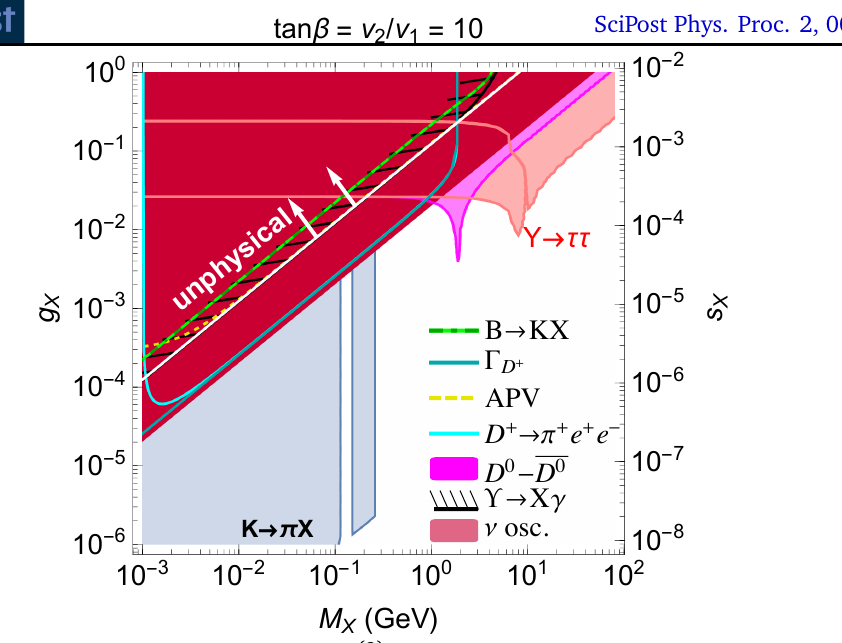
Figure 15.1: Constraints on the U ( 1 ) tan β = 10. For convenience the X − Z mixing, s a given g , the mass of the gauge boson M X unphysical region in the upper left corner of the M white line). The “ ν osc.” bound comes from non standard interaction effects (matter potential) on atmospheric neutrinos. “APV” refers to atomic parity violation.